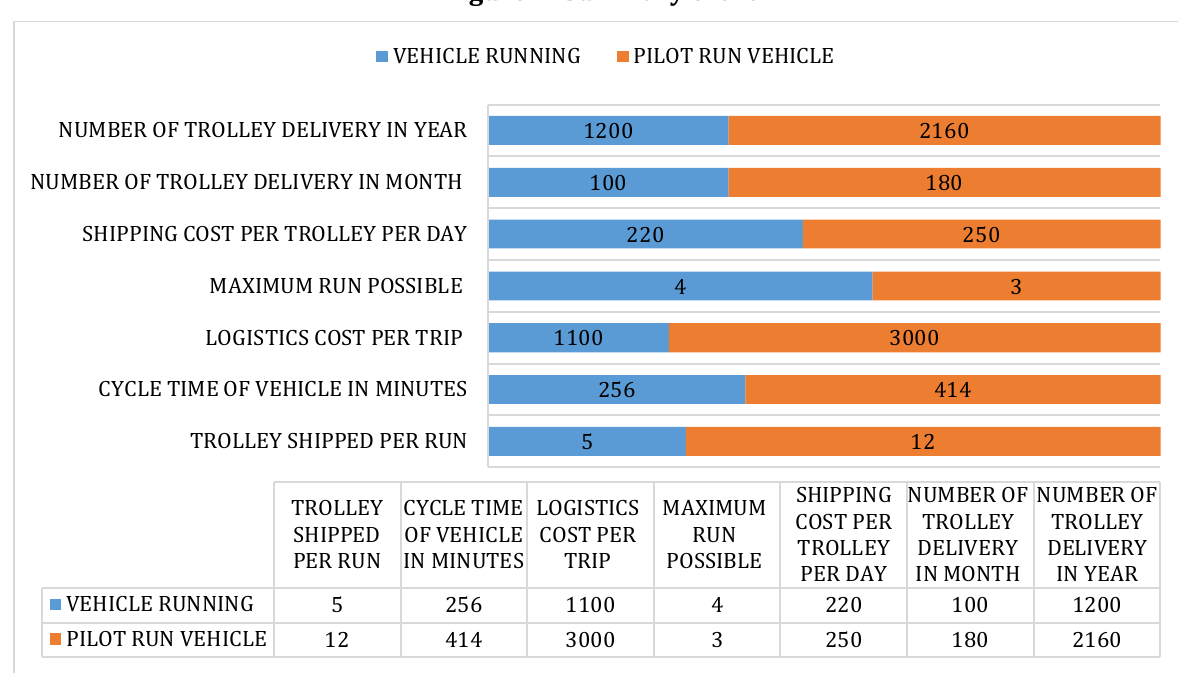
Figure 2: Summary